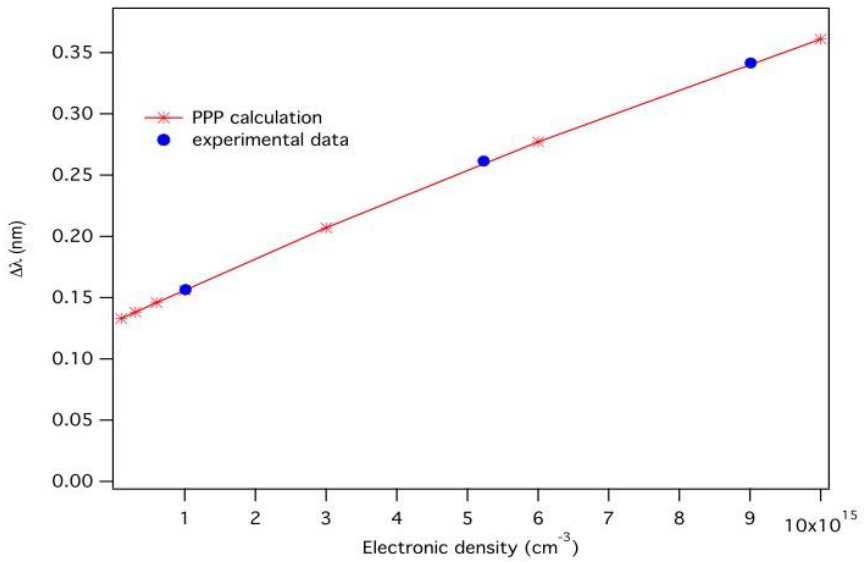
Figure 4. Distance between allowed and forbidden component peaks versus electronic density for He I 492.2 nm line synthesized at T e = 1.16 × 10 4 K and T i = 300 K.